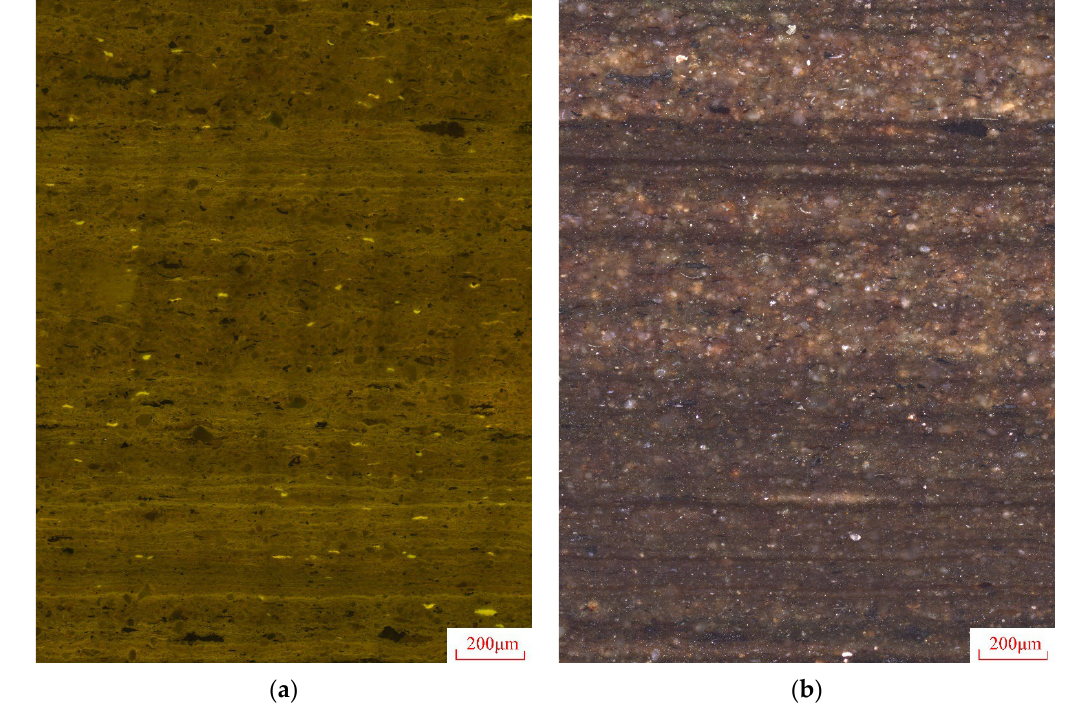
Figure 2. Data preprocessing. ( a ) Stitching result of geometrically corrected fluorescent-light pho- tomicrograph; ( b ) stitching result of reflected-light photomicrograph.